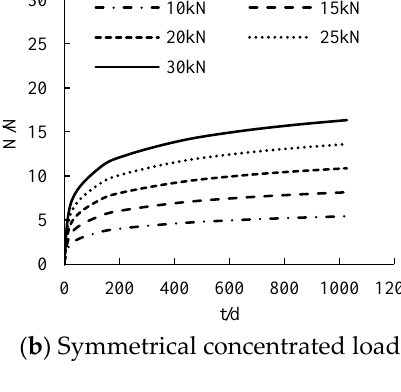
Figure 11. The influence of loading under creep on tensile force.